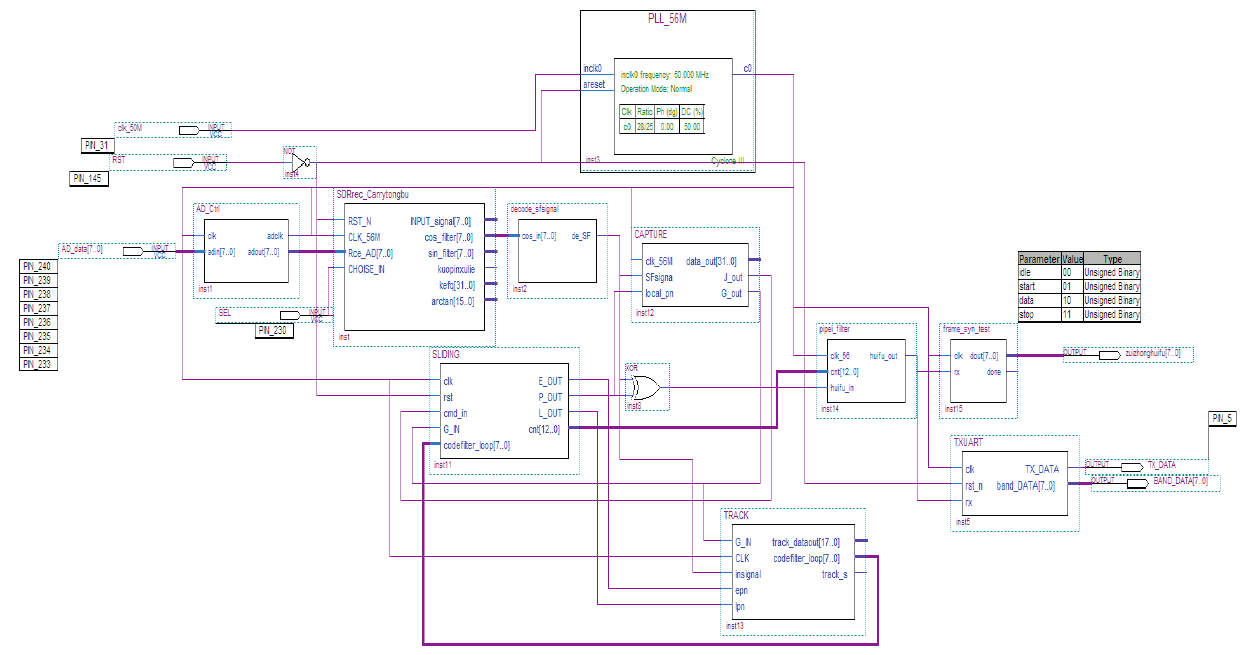
Figure 35. The test setup of the DSSS